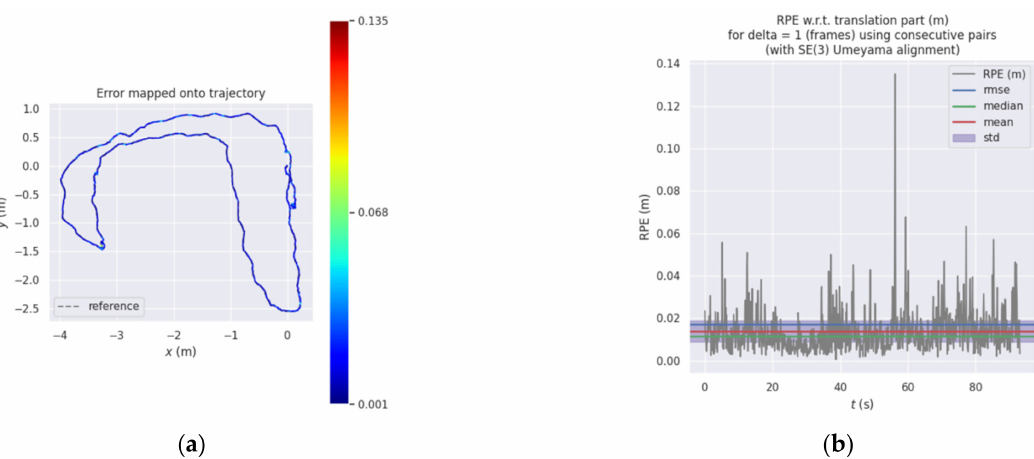
Figure 13. ( a ) Three-dimensional trajectory relative error and ( b ) specific value of relative